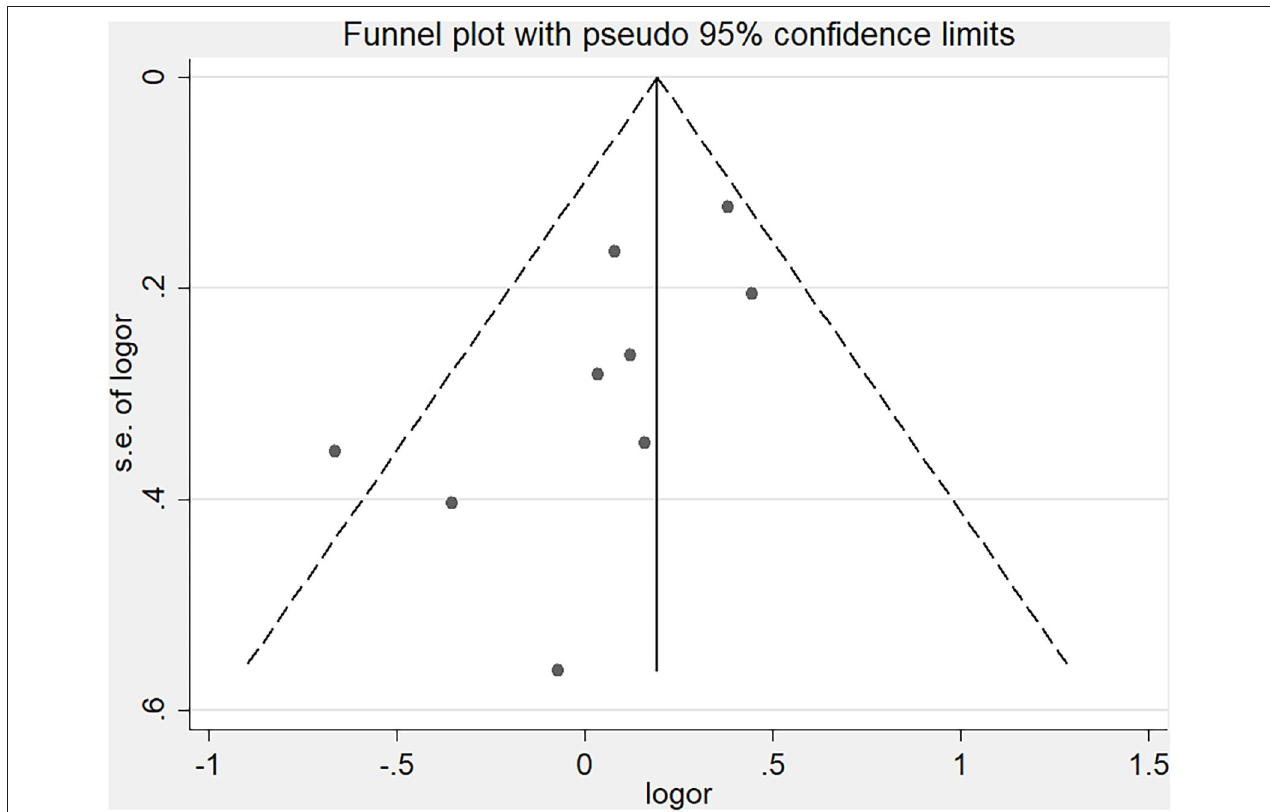
FIGURE 4 | Funnel plot of included